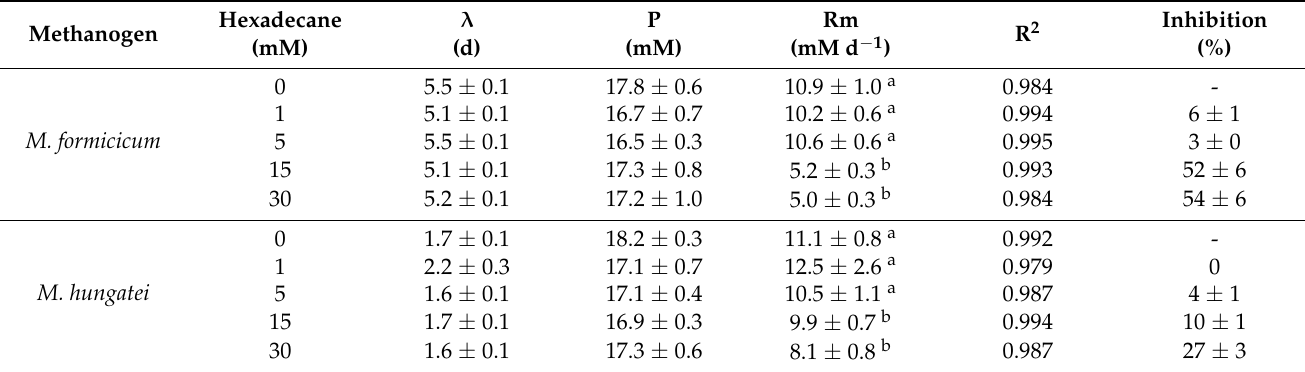
a,b Different letters represent statistically significant differences ( p < 0.05) compared to control (0 mM